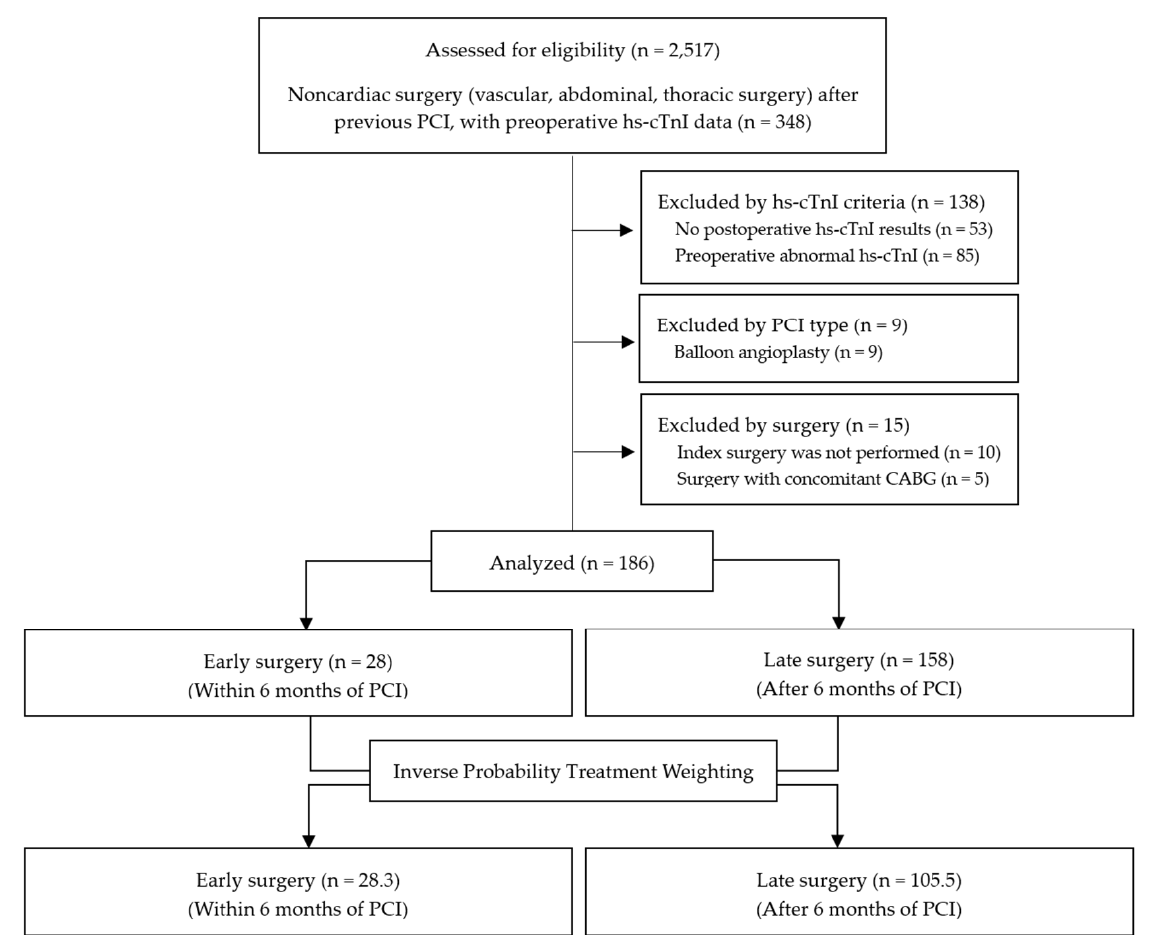
Figure 1. Flow diagram. PCI, percutaneous coronary intervention; Hs-cTnI, high-sensitivity cardiac troponin I; CABG, coronary artery bypass surgery.